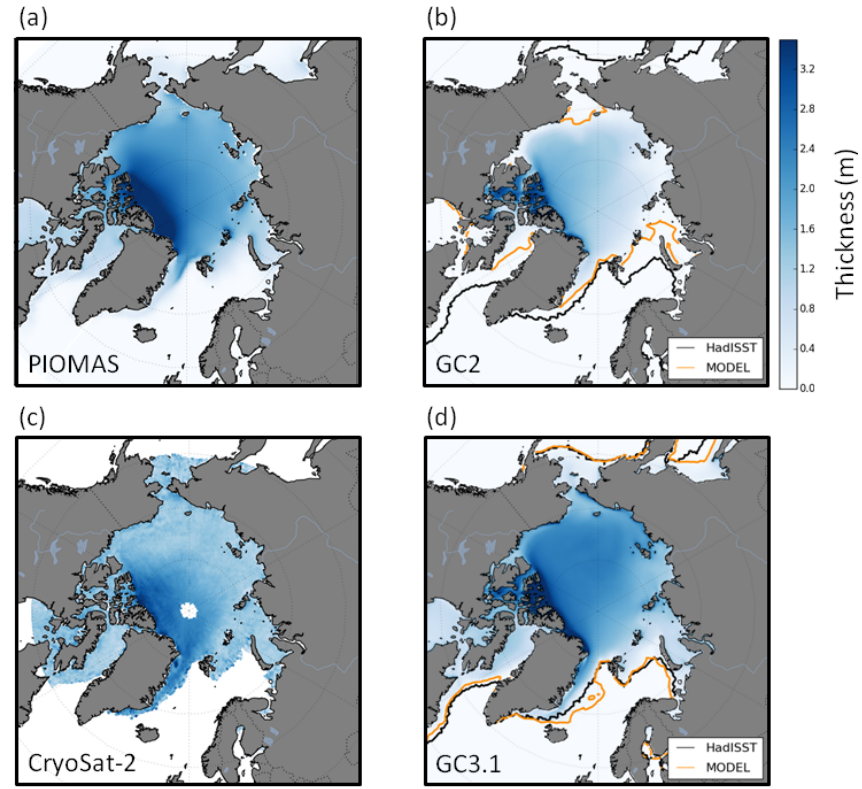
Figure 3. Mean winter (December, January, and February) Arctic sea ice thickness from the HadGEM3-GC3.1 (50-year mean from the year 2000 equilibrium simulation) (b, d) , from the PIOMAS (1990–2009) model reanalysis (a) , and inferred from the CryoSat-2 (2011–2015) sea ice freeboard measurements (c) . The orange and black lines show the 15% ice concentration contours for the model simulations and the HadISST1.2 sea ice analysis respectively.